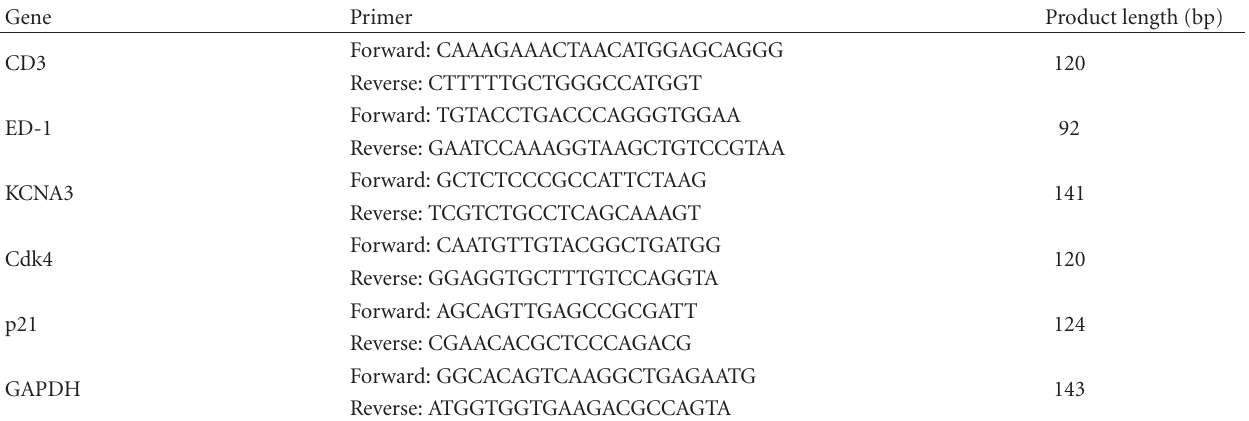
Table 1: Primers used for quantitative real-time reverse